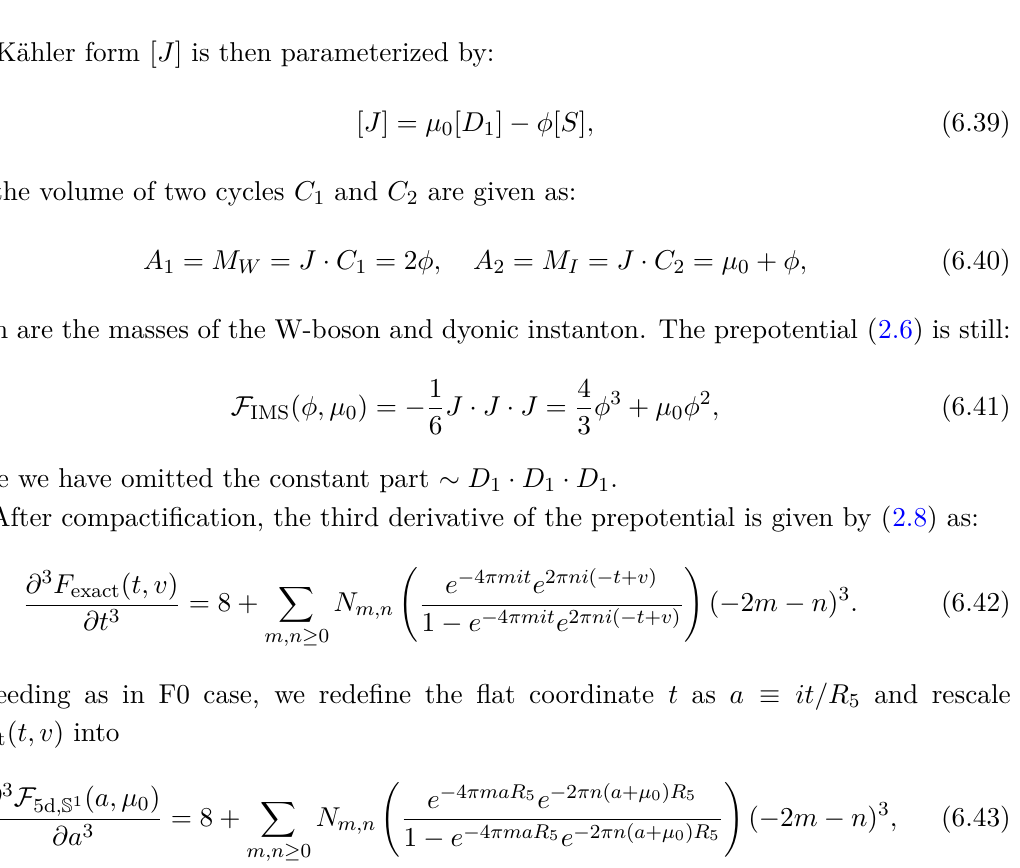
Figure 14 . The toric diagram for F 1